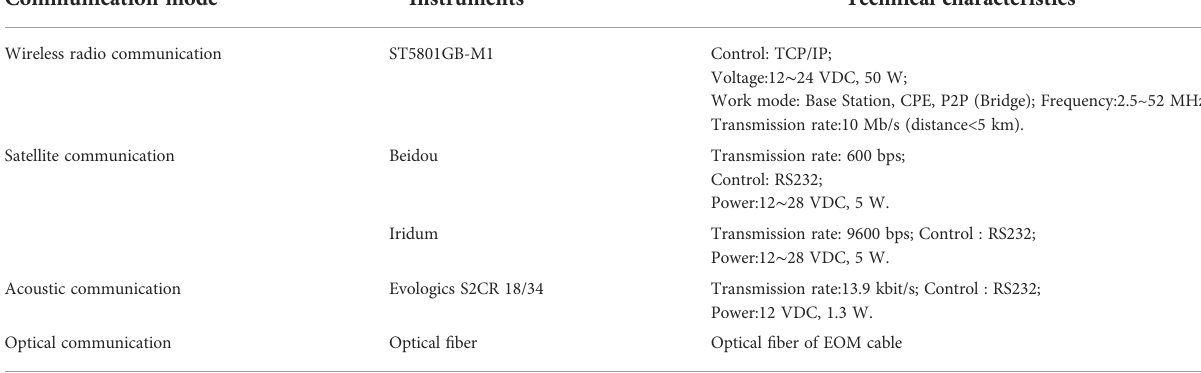
TABLE 3 Types and technical characteristics of communication module.